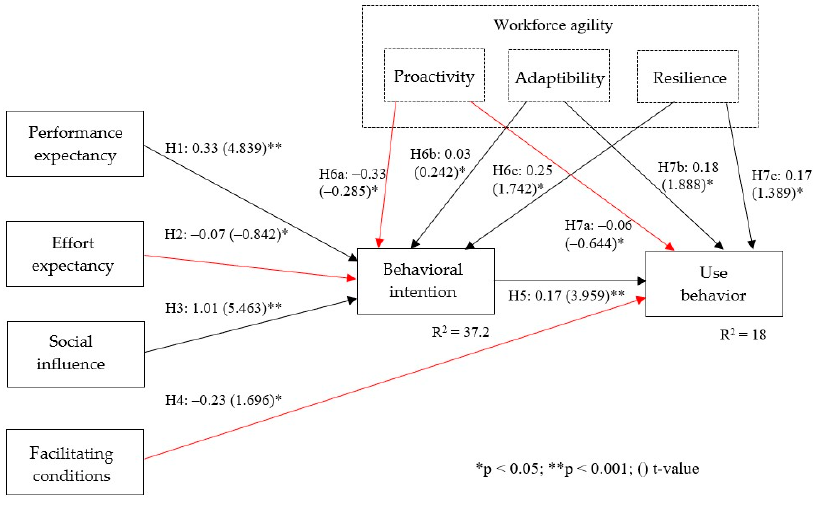
Figure 2. UNS—SEM model.